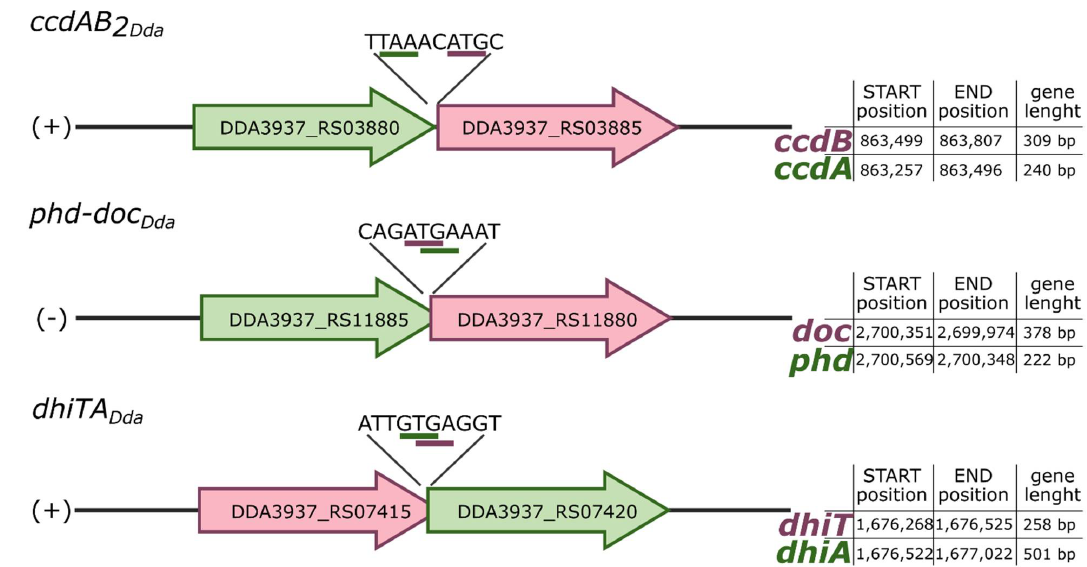
Figure 2. Genetic organization of putative type II toxin-antitoxin (TA) systems predicted in D. dadantii 3937. The arrows (red—putative toxins, green—putative antitoxins) indicate the direction of the transcription and do not represent the exact length of the genes. Genomic location of TA systems in the chromosome of D. dadantii 3937 and gene length are presented in the tables. The NCBI ID numbers for each putative toxin or antitoxin are depicted in the figure. ccdAB 2Dda